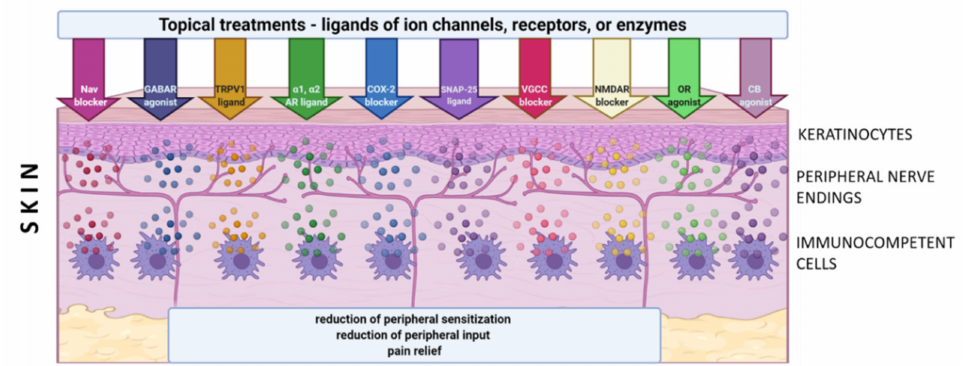
Figure 3. Topical treatments utilized in clinical practice in patients suffering from neuropathic and/or inflammatory pain, and their suggested molecular/cellular targets. Abbreviations : Nav—voltage-gated sodium channels, TRPV1—transient receptor potential vanilloid 1, VGCC—voltage-gated calcium channels, NMDAR—N-methyl-D-aspartate receptors, α 1- AR— α 1 adreno receptors, α 2-AR— α 2 adreno receptors, GABAR—gamma-aminobutyric acid receptors, OR—opioid receptors, CB- cannabinoid receptors, COX-2—cyclooxygenase 2, SNAP-25—synaptosome-associated protein 25. Created with